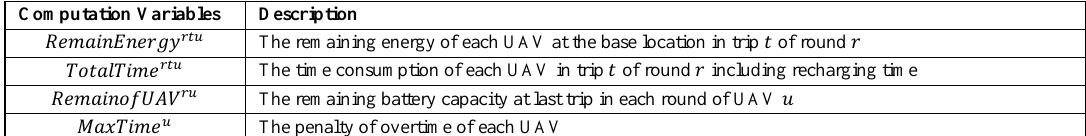
Table 2. Computation variables.